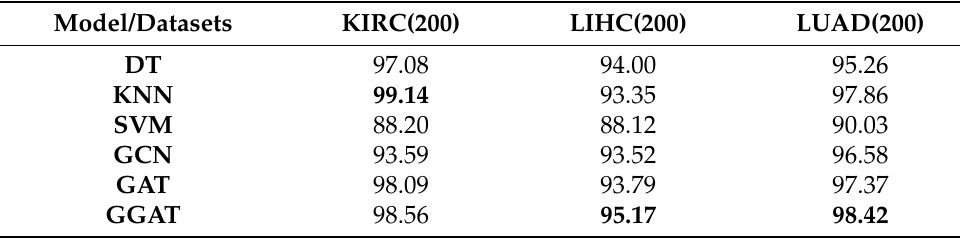
Table 11. Accuracy (%) of Models Under 200 Feature Dimensions.